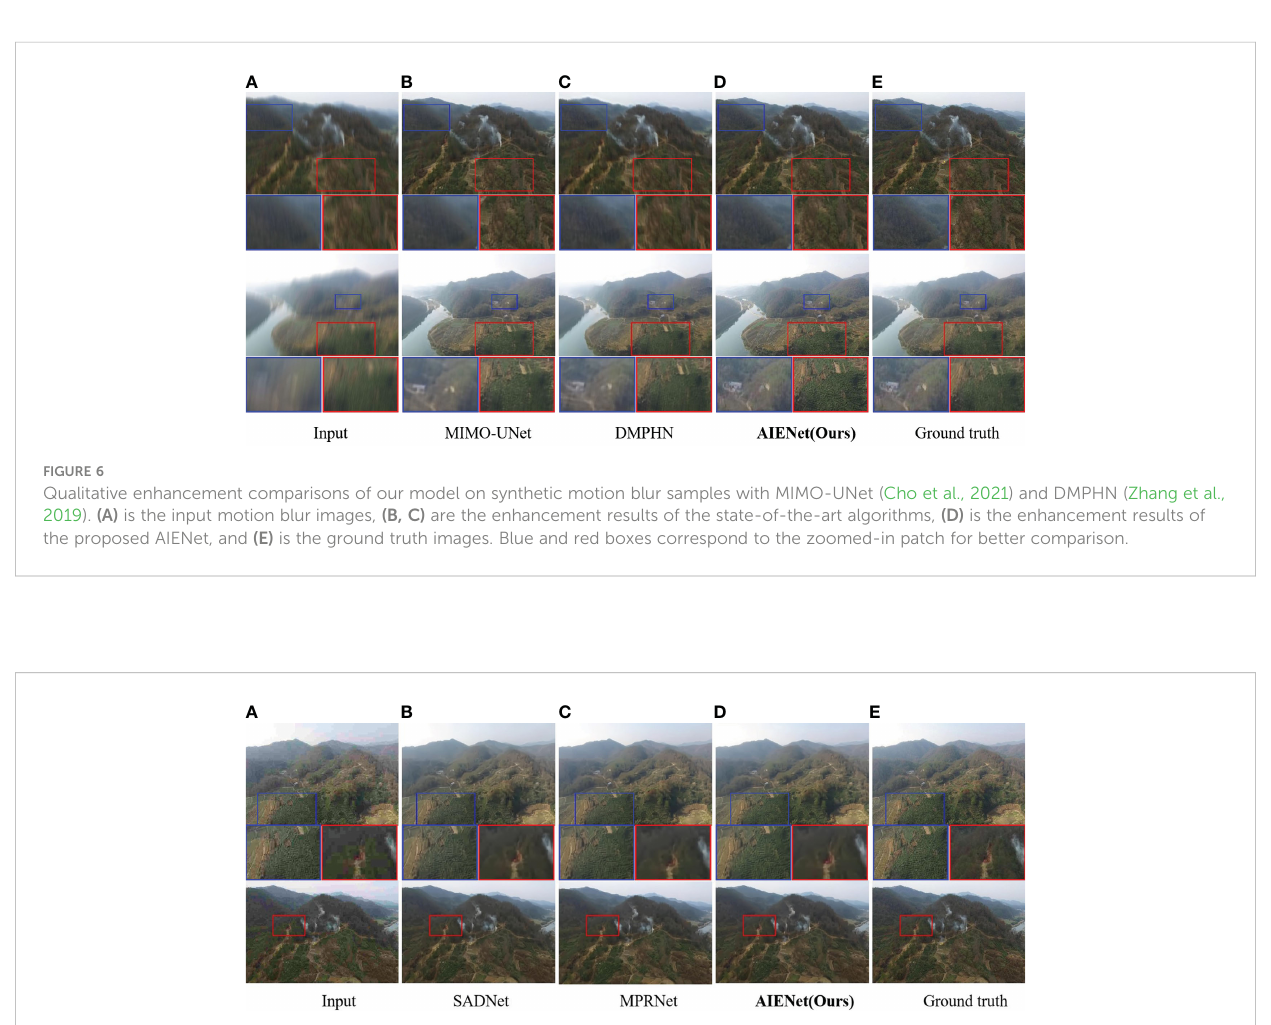
FIGURE 7 Qualitative enhancement comparisons of our model on synthetic compression blur samples with SADNet (Chang et al., 2020) and MPRNet (Zamir et al., 2021). (A) is the input compression blur images, (B, C) are the enhancement results of the state-of-the-art algorithms, (D) is the enhancement results of the proposed AIENet, and (E) is the ground truth images. Blue and red boxes correspond to the zoomed-in patch for better